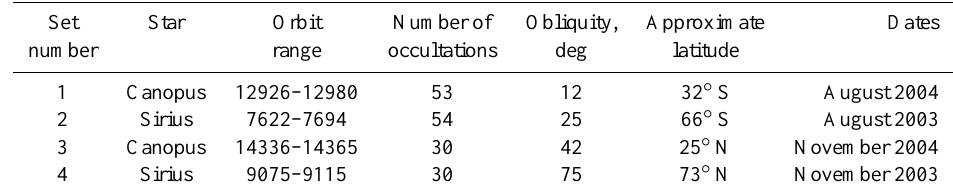
Fig. 1. Retrieval results for occultation of Sirius at the orbit 7673 ( α =23 ◦ , 19 August 2003, under ray perigee point 65 ◦ S 58 ◦ W). Blue lines: modeling errors are ignored ( C = C noise ) , red lines: FCM inversion. The inversion has been performed with the GOMLAB modeling environment. The black dashed line in the subplot for χ 2 indicates χ 2 norm =1.